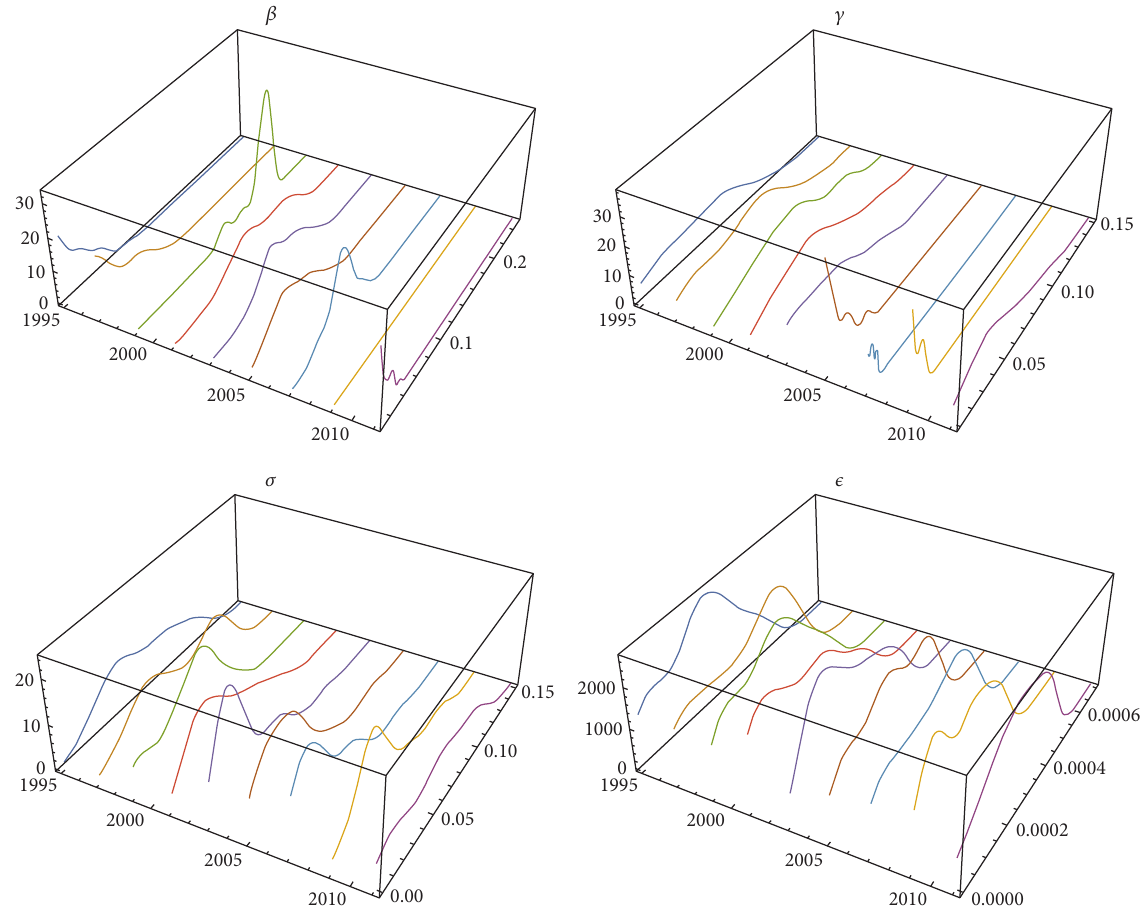
Figure 3: Estimation of the random processes 𝛽 𝑡 , 𝛾 𝑡 , 𝜎 𝑡 , and 𝜖 𝑡 using the estimated PDF of the parameters in the time instants in Ω